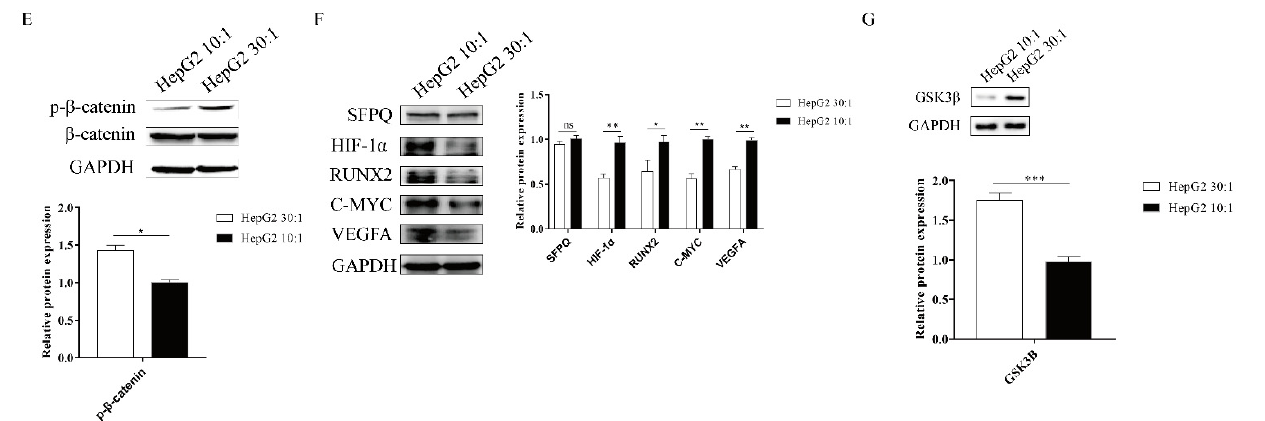
Figure 3. Matrix stiffness signals promote EMT through activating the WNT/ β -Catenin pathway. ( A – C ) Effect of substrate stiffness on the EMT phenotype. HepG2 cells are cultured on 3D micropillars (10:1, 30:1) for 48 h. ( A , B ) Western blot and ( C ) IF analysis of phenotypic markers and TF. (Scale bar: 100 µ m). ( D – G ) Effect of substrate stiffness on the WNT/ β - Catenin pathway. ( D ) Investigation of the localization of β -Catenin by IF in HepG2 cells. HepG2 cells were cultured in 3D micropillars (10:1, 30:1) for 72 h. IF analysis of β -Catenin localization. (Scale bar: 100 µ m). ( E ) HepG2 cells were cultured in 3D micropillars (10:1, 30:1) for 48 h. Western blot analyzed the expression of p- β -Catenin and β -Catenin. ( F ) HepG2 cells were cultured in 3D micropillars (10:1, 30:1) for 48 h. Western blot analyzed the expressions of the downstream of WNT/ β -Catenin protein. ( G ) HepG2 cells were cultured in 3D micropillars (10:1, 30:1) for 48 h. Western blot analysis of the expression of GSK3 β . *, p < 0.05; **, p < 0.01; ***, p < 0.001; and ns, not